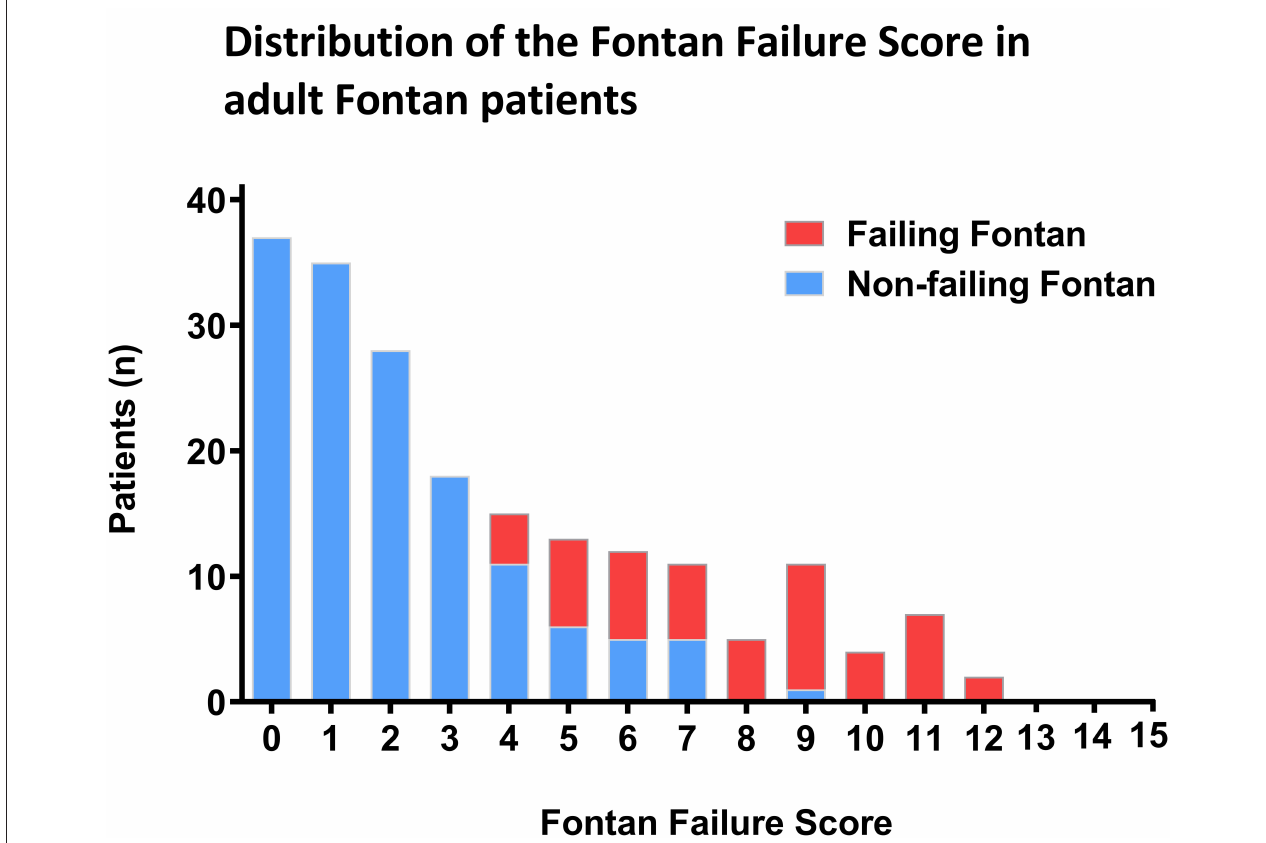
FIGURE 2 | Distribution of the Fontan Failure Score in our cohort of adult patients. Columns represent number of patients stratified for those with (red) and without (blue) Fontan failure. The abscissa indicates summed points of the Fontan Failure Score.